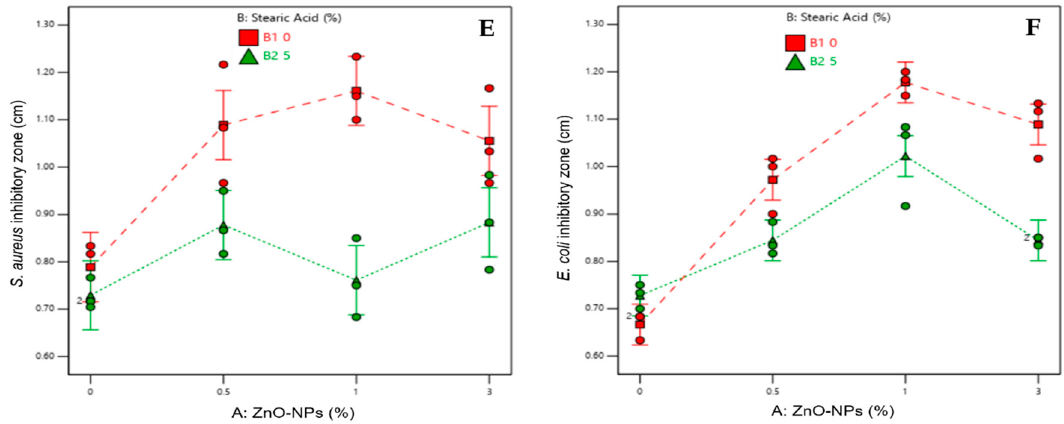
Figure 2. Interaction effect of ZnO-NPs and SA: ( A ) WVTR; ( B ) % elongation at break; ( C ) tensile strength; ( D , E , F ) antibacterial against B. cereus , S. aureus , and E. coli , respectively.